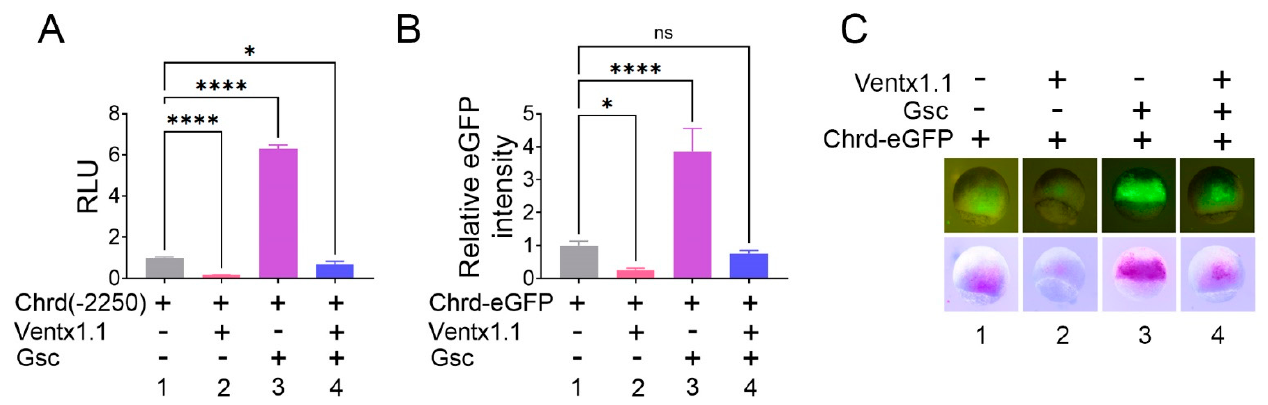
Figure 2. The chrd(-2250) promoter region contains the positive and negative response elements for Gsc and Ventx1.1., respectively. ( A ) chrd(-2250) was injected with or without gsc (1 ng/embryo) and ventx1.1 (1 ng/embryo) at the one-cell stage. The luciferase reporter gene assay was performed at stage 11. ( B ) The quantification of eGFP relative fluorescence was analyzed with the embryos shown in ( C ). The chrd(-2250)eGFP was injected with or without gsc (1 ng/embryo) and ventx1.1 (1 ng/embryo) at the one-cell stage, and fluorescent analysis was performed at stage 10.5. * p ≤ 0.1, **** p ≤ 0.0001, and n.s. denotes nonsignificant values.